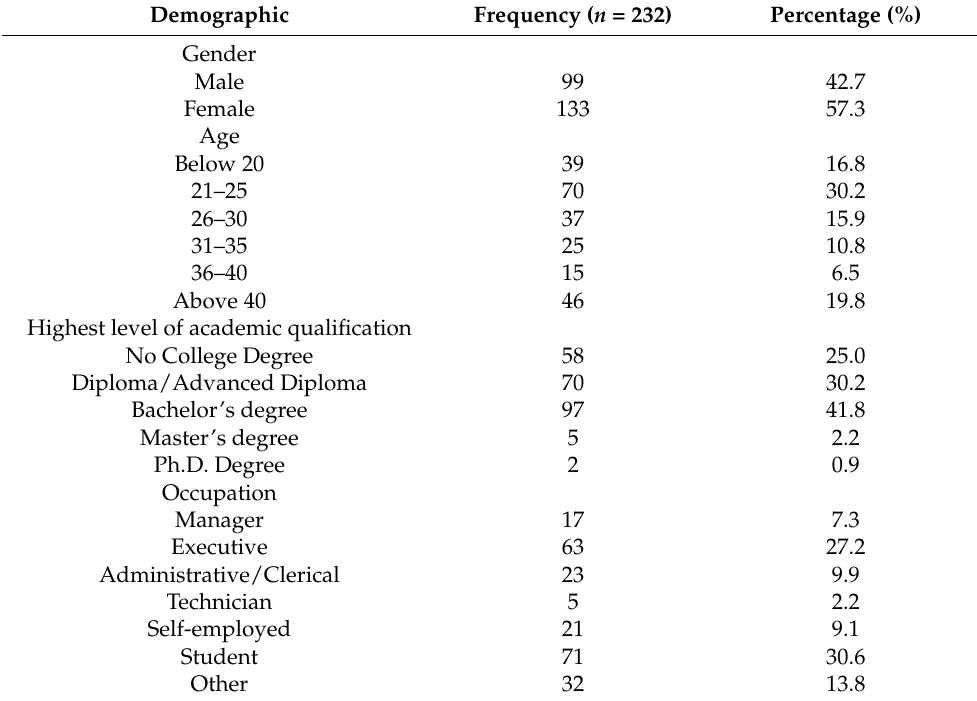
Table 1. Respondents’